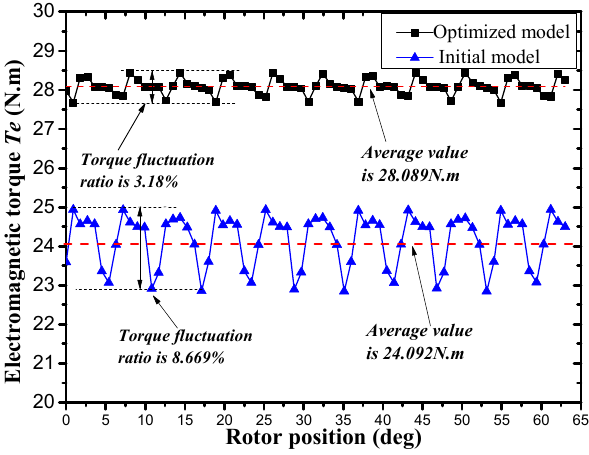
Figure 20. Electromagnetic torque of the optimized model.